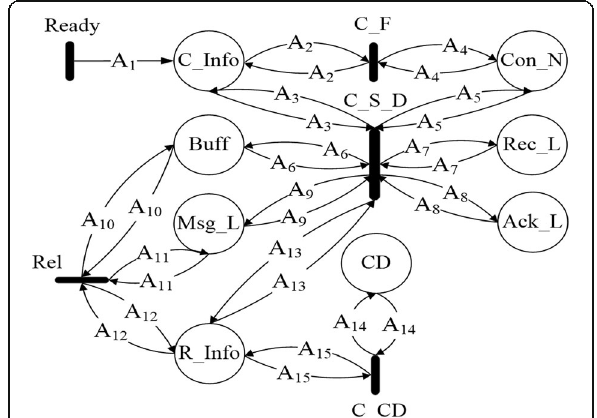
Fig. 4 HLPN model of the FAR